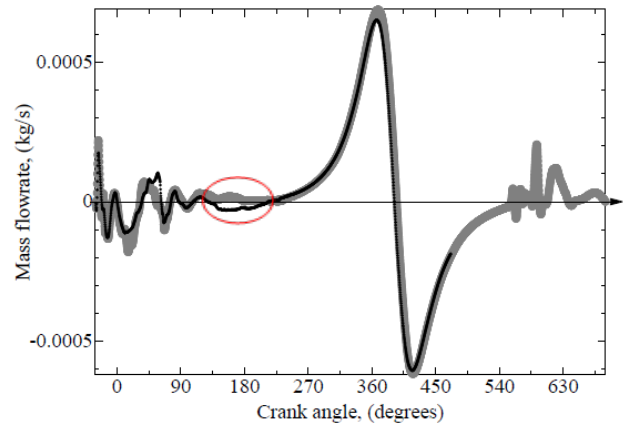
Figure 8. Comparison of mass flow rate differences between inlet and outlet ducts of chamfered design (gray line) and the sharp-edge design (black line) of the prechamber.